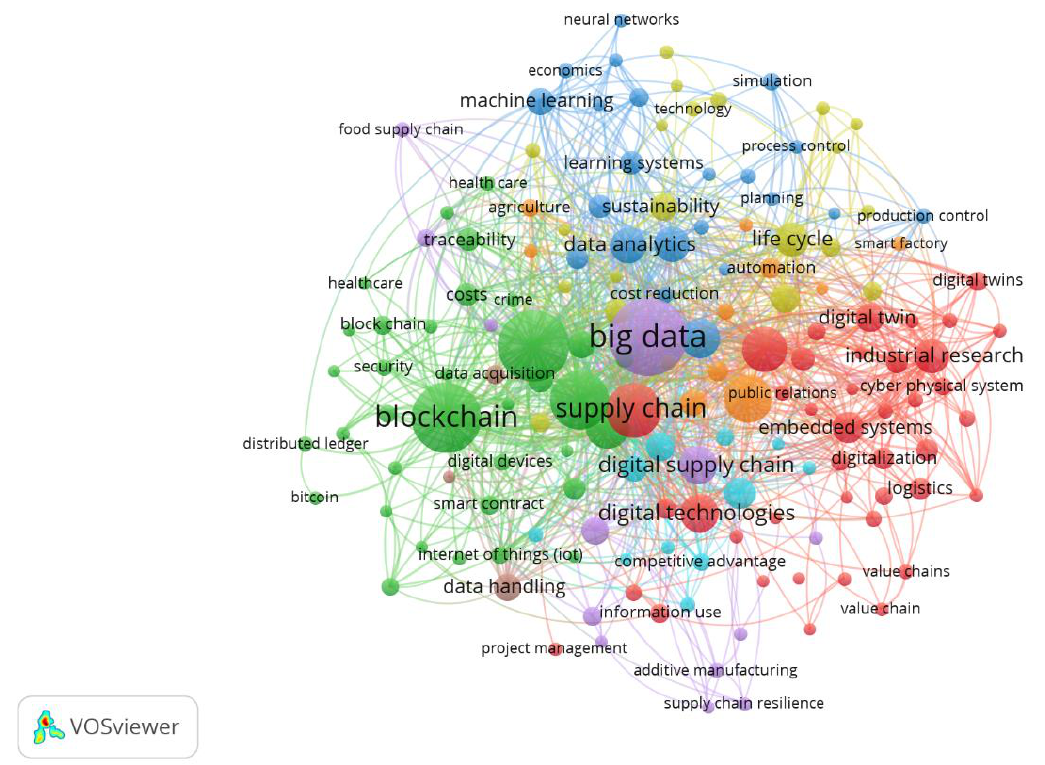
Figure 3. Keyword occurrence in the selected papers.